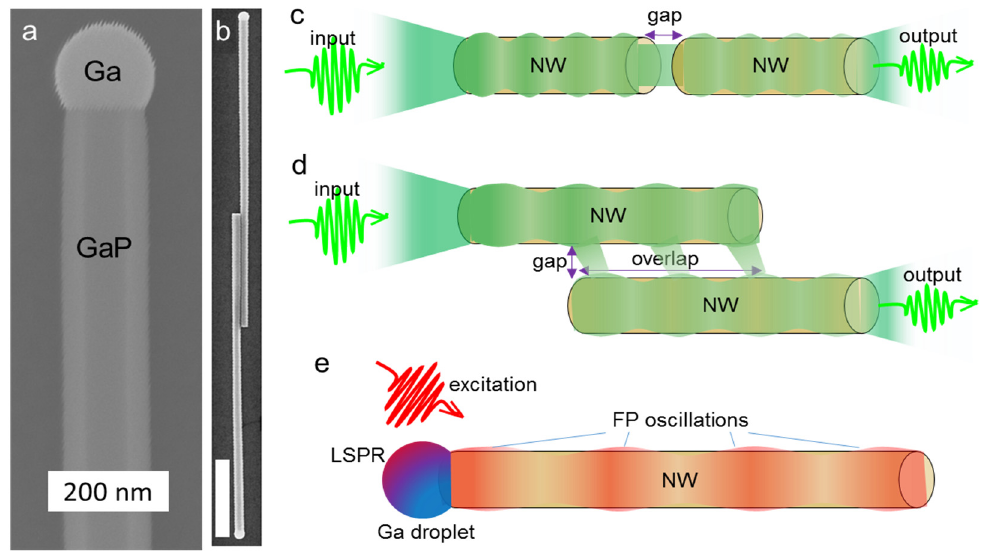
Figure 1. GaP NWs and phenomena understudy. SEM images of ( a ) GaP NW with Ga droplet, ( b ) planarized overlapped GaP NWs representing coupled waveguides optical system, scale bar—1 µm; schematics of the modeled systems: ( c ) two aligned GaP NWs waveguiding system, ( d ) wave- guiding in parallel GaP NWs, and ( e ) size-dependent resonant phenomena in individual GaP NW.